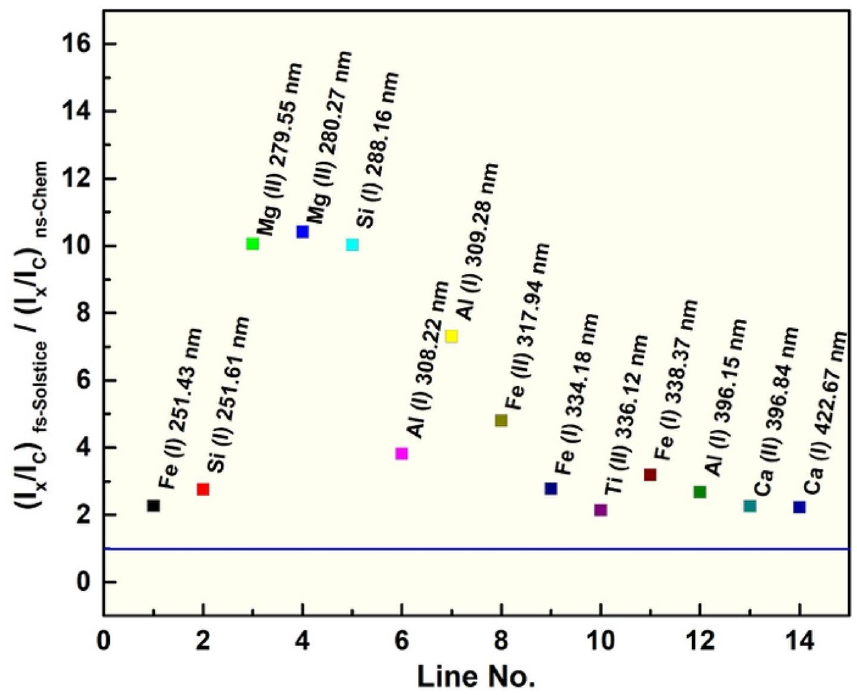
Figure 4. Relative sensitivity factors for 6 mineral elements: Fe, Si, Mg, Al, Ti, and Ca in coal matrix vary between 2 to 10 showing enhanced sensitivity of fs-Solstice system relative ns-Chem system for minerals